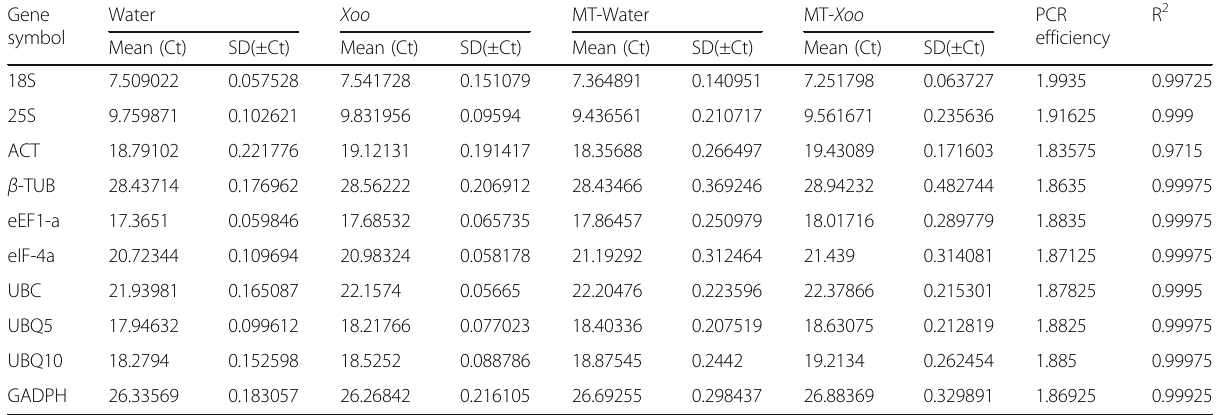
Table 2 Mean Ct values and amplification efficiency of candidate internal reference genes Gene